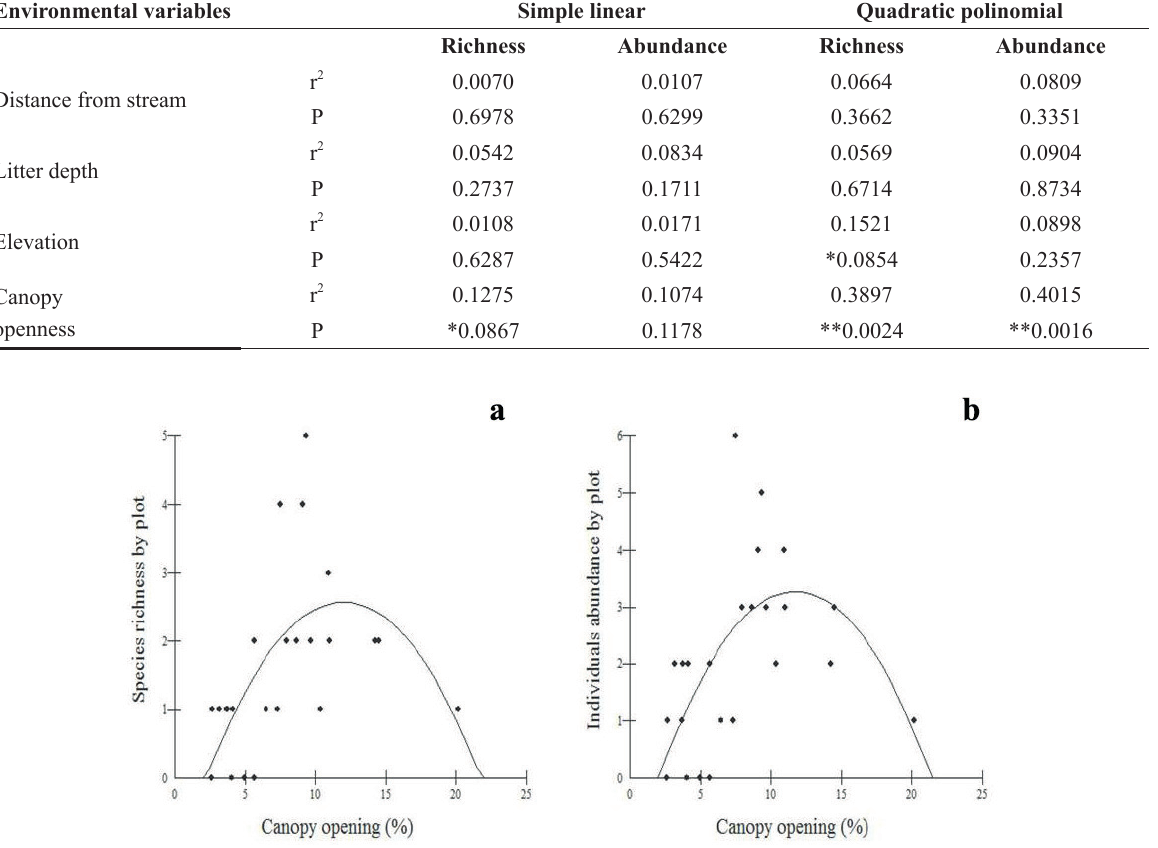
Figure 2 - Relationship between the percentage of canopy openness with ( a ) richness and ( b ) abundance of snakes in an upland forest in Central